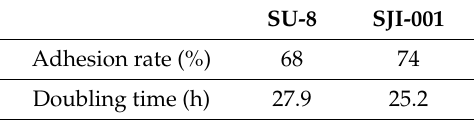
Figure 5. Proliferation curve of HeLa cells on SJI-001 and SU-8. HeLa cells seeded on SU-8 and SJI-001 proliferated and were confluent after 7 and 9 days, respectively. Table 1. Adhesion rate and doubling time of HeLa cells on S SU-8 and SJI-001.